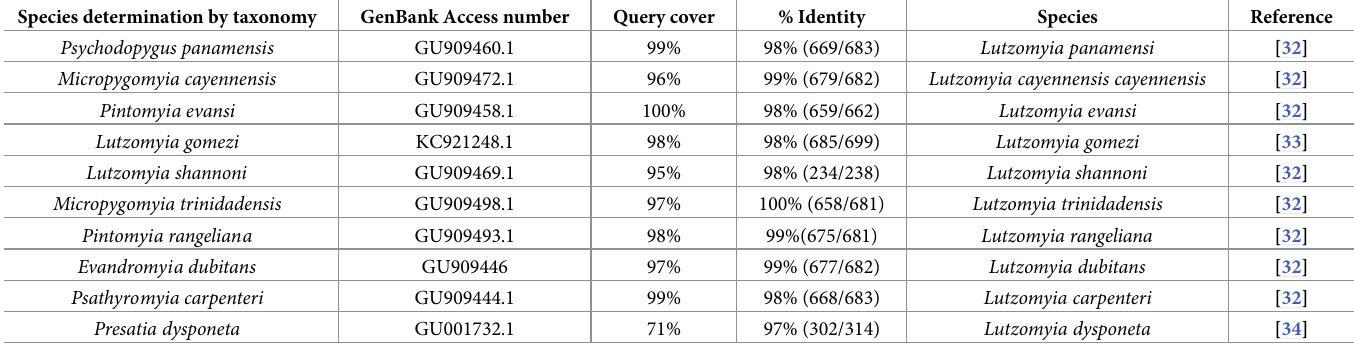
Table 2. Results from DNA barcode analyses for species identification confirmation. Samples were collected in 24 houses in each of 15 localities in the Cordoba department in Colombia a subset of the collected specimens were DNA barcoded suing standard protocols and primers. The table shows the species identity according to morphology-based taxonomy and the reference sequence genbank number and ID for that species. All the samples belonged to single female specimens except for P . evansi specimens that were a pool of 10 individuals. We show the percentage of barcodes produced for each nominal species that matched the reference sequence, in parenthesis the number of matching nucleotids and total number of produced barcodes. References correspond to publications of the reference